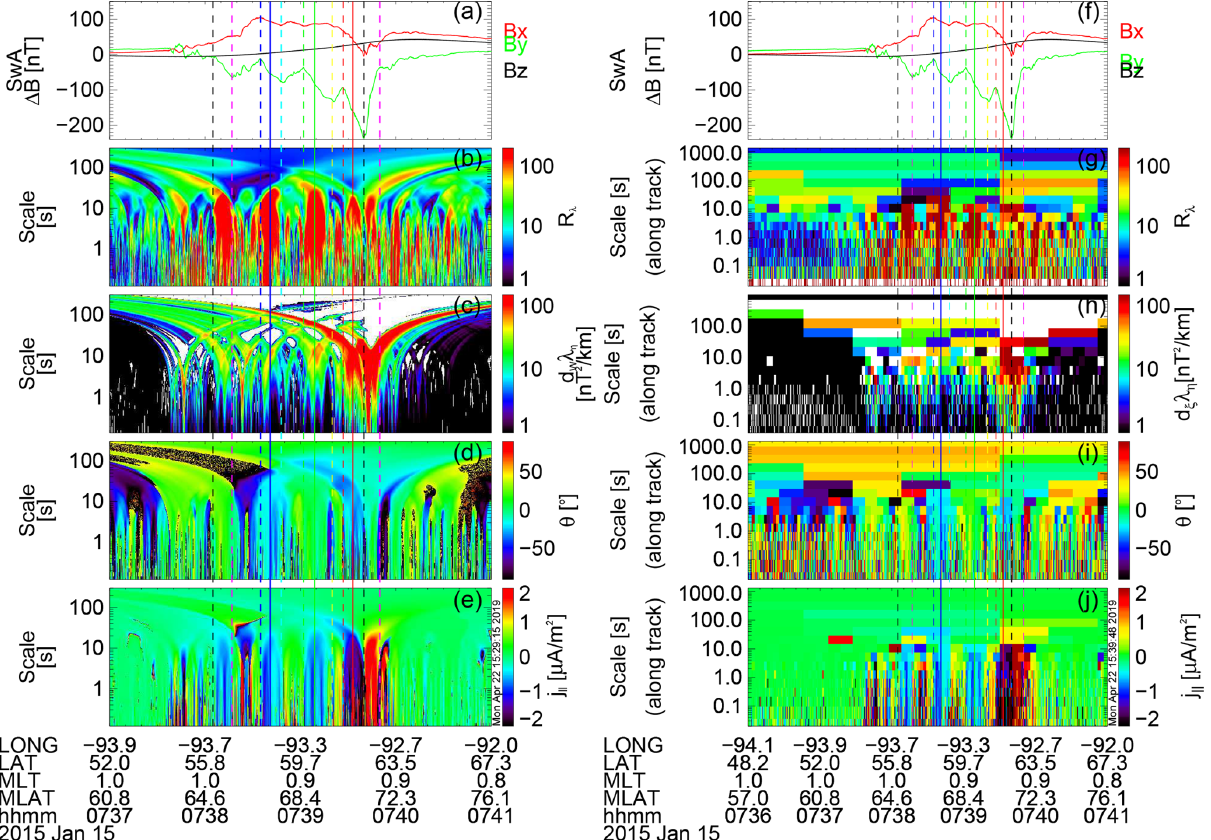
Figure 9. Same panels as in Fig. 5. The vertical solid lines indicate the center times of U2 (blue), U3 (green), and U4 (red) FACs for which we show the sections in Fig.